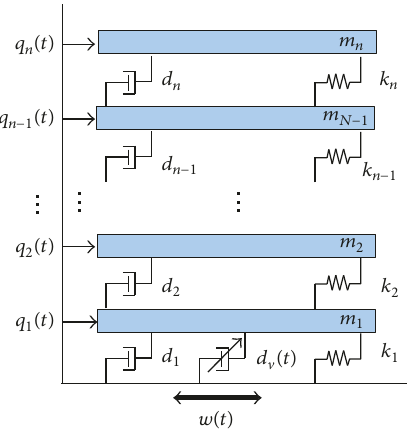
Figure 1: 𝑛 -DOF structural system with 𝑛 𝑠 semiactive dampers.